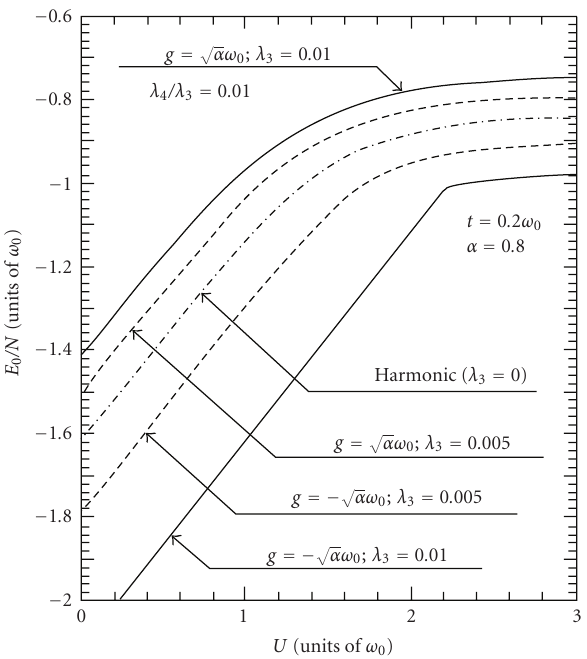
Figure 8: Ground-state energy per site as a function of U